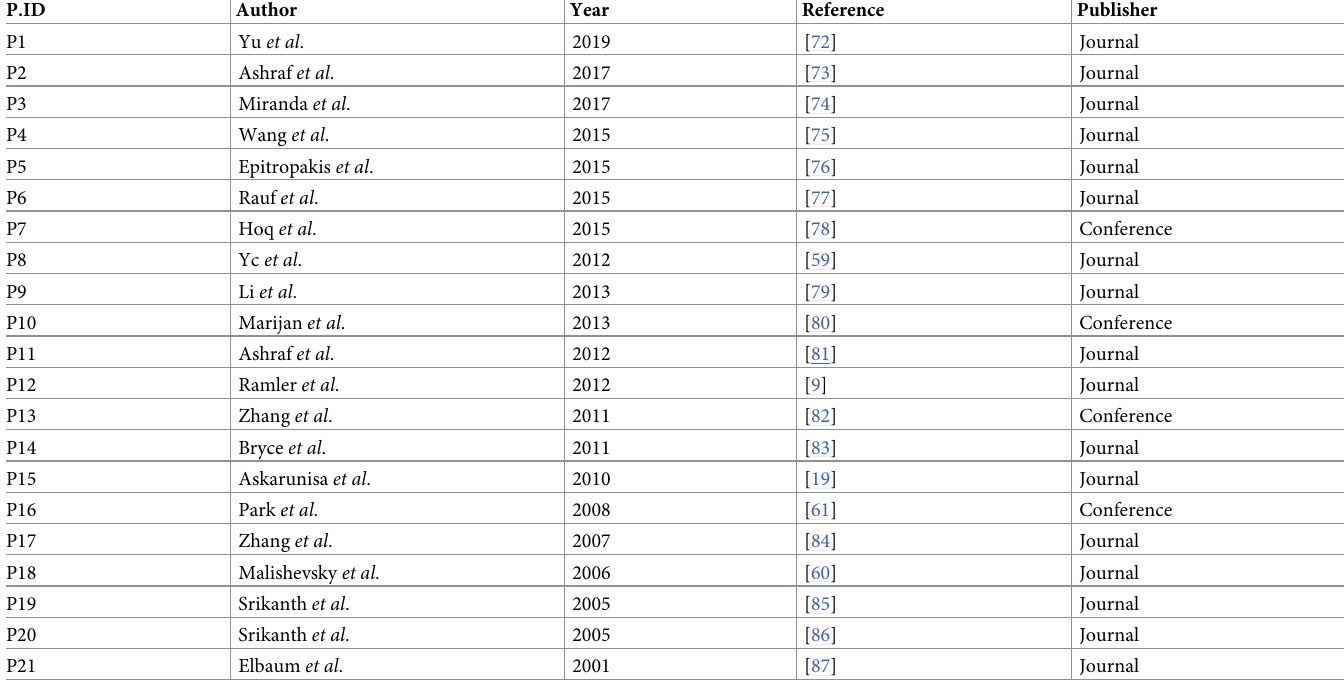
Table 8. Research trends of value-based cost-cognizant TCP techniques.